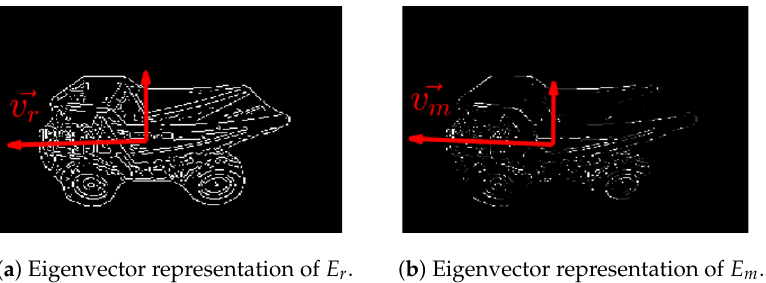
Figure 7. E m and E r with their respective eigenvectors centred in the centroids of the two images. ( a ) E r and its eigenvectors. ( b ) E m and its eigenvectors.